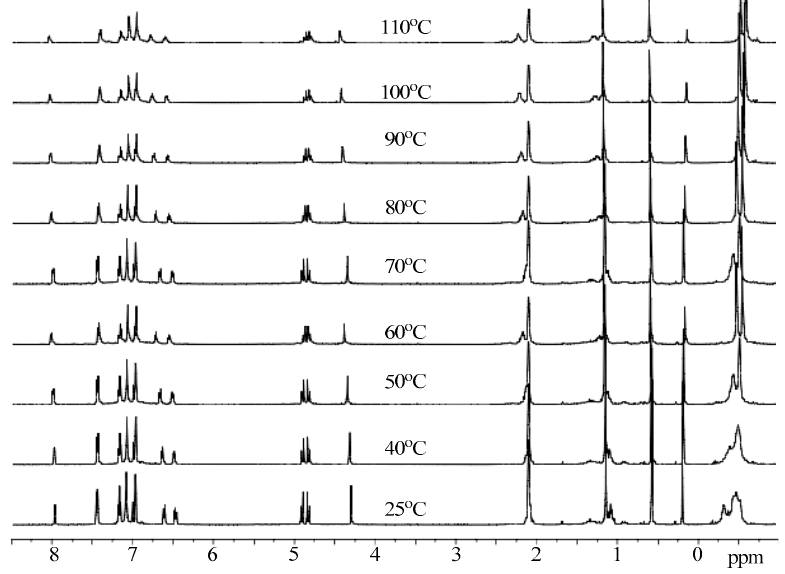
Figure 9. VT- 1 H NMR spectra of C1 /BnOH recorded between 25 and 110 °C (in toluene- d 8 ).